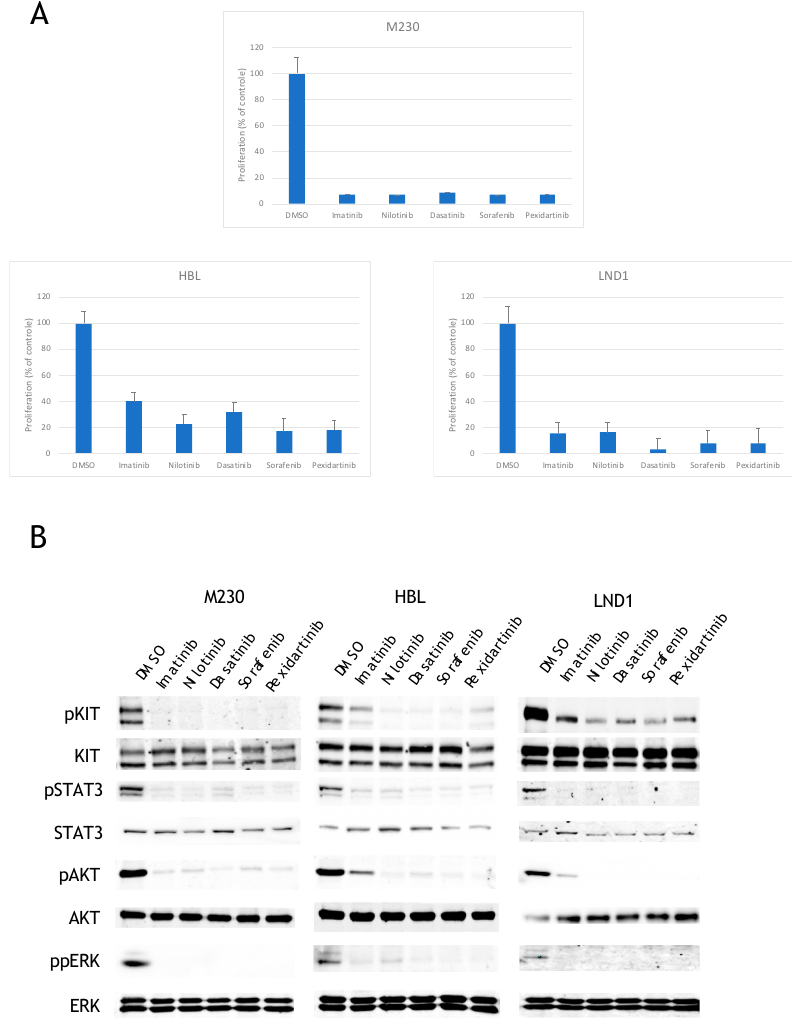
Figure 1. E ff ects of KIT inhibitors on proliferation and signaling. ( A ) Cells were treated with DMSO or 1 µ M of inhibitors and proliferation was analyzed after 3 days (data are represented as mean +/ − SD). All inhibitors induced a significant inhibition a proliferation in the three cell lines ( p < 0.001; unpaired t -test). ( B ) Cells were treated for 24 h with DMSO or 1 µ M inhibitors and the levels of phosphorylated proteins or total proteins were analyzed by Western